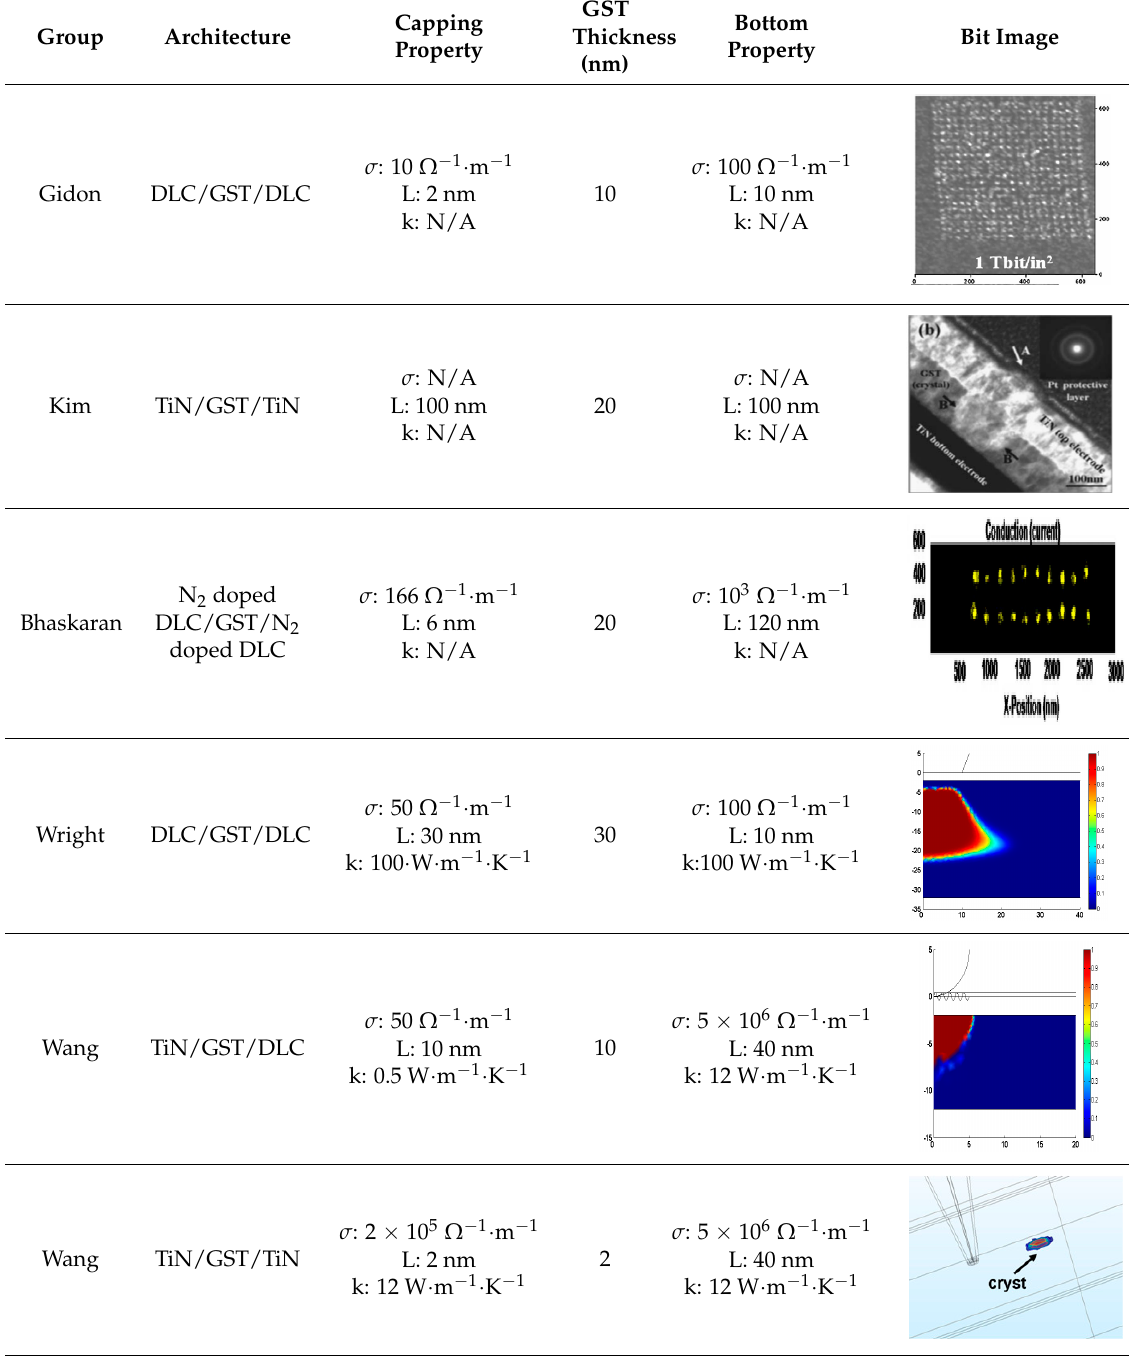
Figure 24. Schematic of the thermal probe storage system using phase change media when operated in ( a ) writing mode and ( b ) readout mode. Reproduced with permission from [54]. Copyright Nature, 2006. Table 2. Characteristics of phase-change electrical probe memories proposed by different groups.